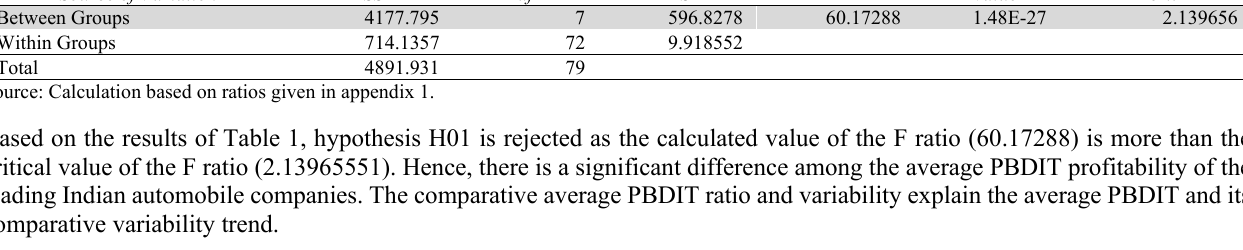
ANOVA of PBDIT ratio of Indian leading automobile companies Source of